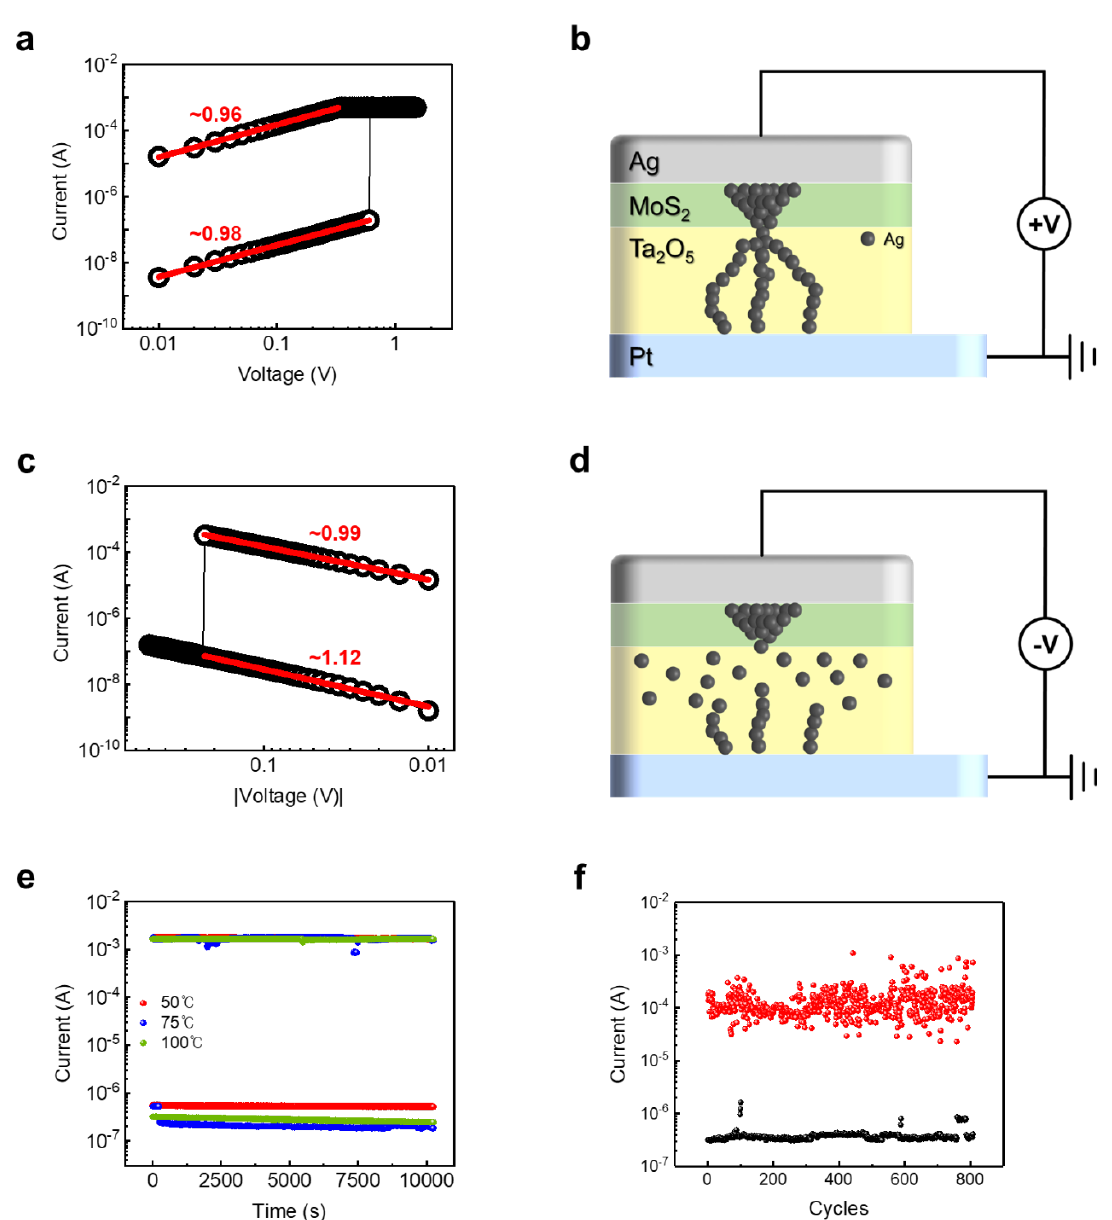
Figure 3. Conduction mechanism and stability for memory application of Pt/Ta 2 O 5 /MoS 2 /Ag device. ( a , c ) Double logarithmic I – V characteristics of set and reset processes, respectively, where red solid lines indicate the linear fitting. ( b , d ) Schematic illustration of RS mechanism for set and reset processes, respectively. ( e ) Retention properties at 50 °C, 75 °C, and 100 °C for 10,000 s. ( f ) Endurance properties over 800 cycles.